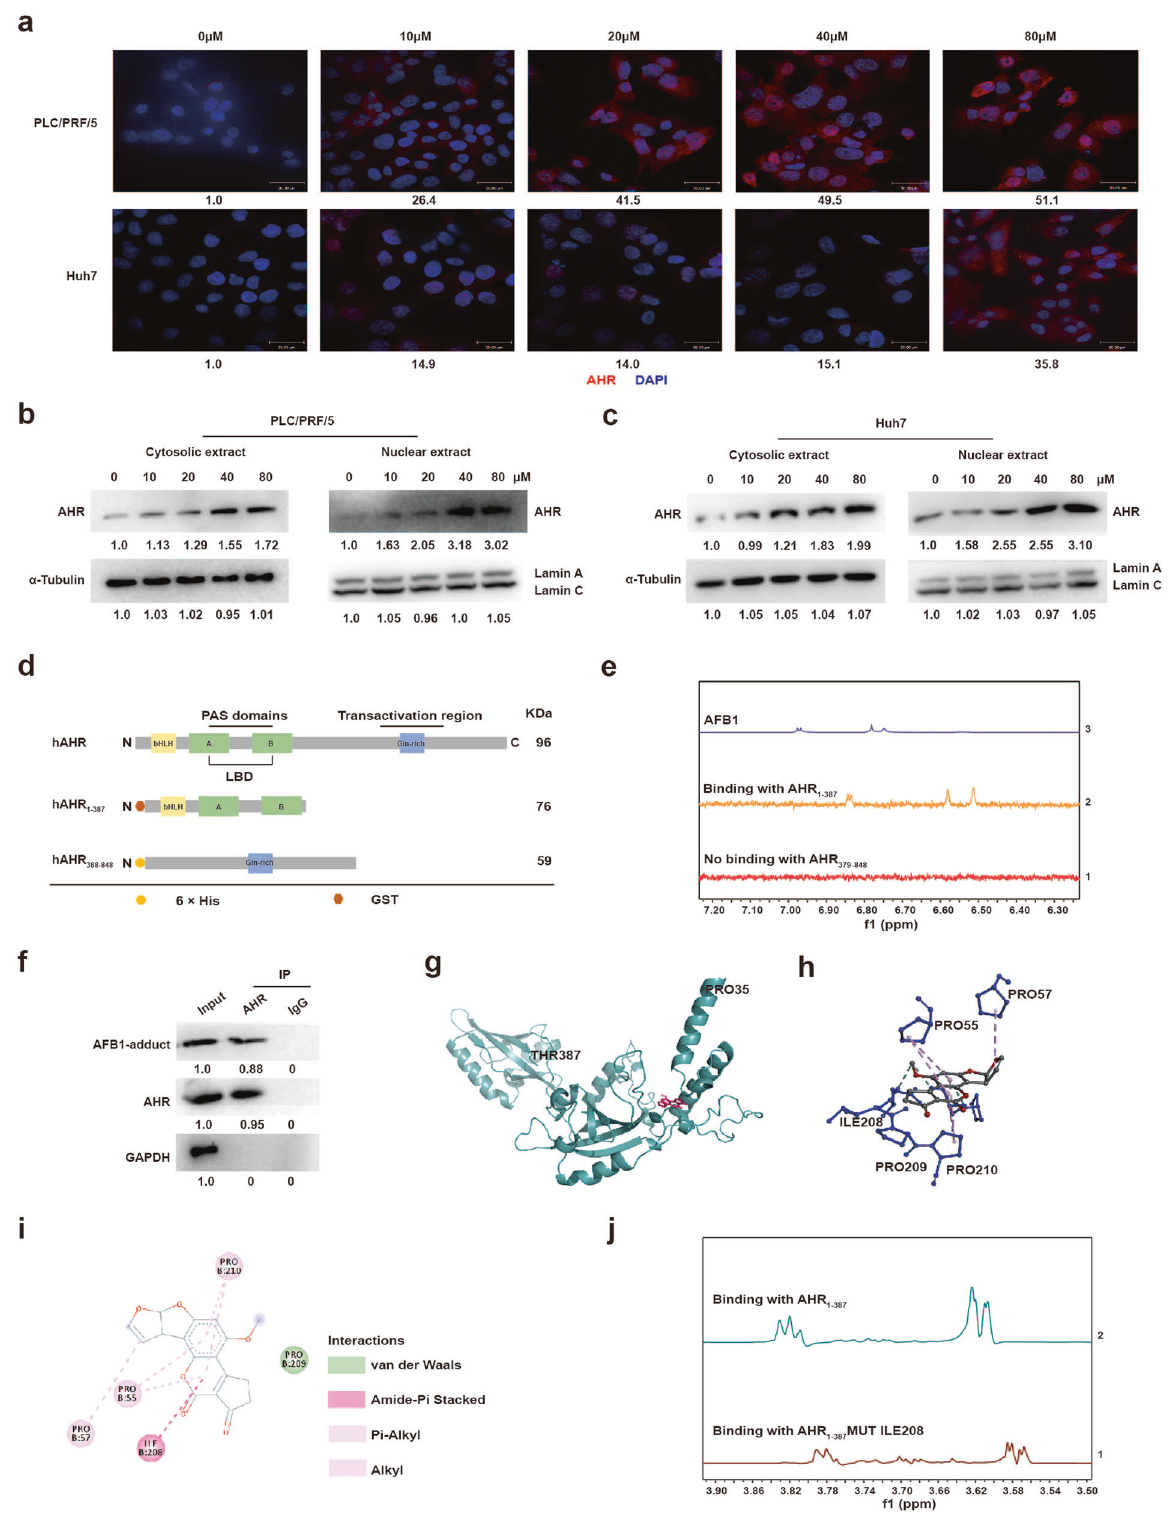
Fig. 5 AFB1 activates AHR nuclear translocation and the N-terminus domain of AHR binds to AFB1. a Images of immuno fl uorescence staining to localize AHR (red) in PLC/PRF/5 and HuH7 cells with AFB1 treatment. DAPI (blue) was used to stain the nucleus. b , c Western blot analysis of AHR in b PLC/PRF/5 and c HuH7 cells. Cytosolic extracts are analyzed in panels on the left; nuclear extracts in panels on the right. d Domain structures of AHR N- and C-terminal recombinant proteins. e STD analysis of the AHR recombinant proteins bound to 20 µM AFB1. f Western blot analysis of co-IPs to assess the binding between AHR and AFB1. g The de novo modeling of AHR 1 – 387. h The binding model of AFB1 on the molecular surface of AHR 1 – 387. i The interaction model of AHR 1-387 with AFB1. j STD analysis of the AHR 1 – 387 -Mut-ILE280 recombinant proteins with 20 µM AFB1